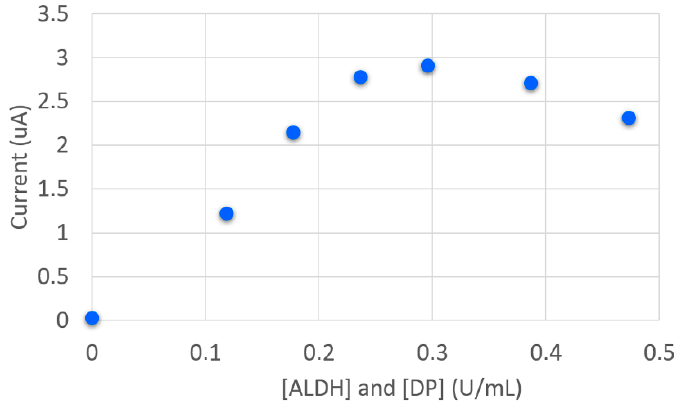
Figure 3. Calibration plot obtained with different concentrations of ALDH and DP (ratio = 1) and 1 mM NAD + , 1 mM K 3 [Fe(CN) 6 ], 2 mM PPA and 0.1% BSA in 0.1 M phosphate + 0.1 M KCl buffer solution pH 8.0.